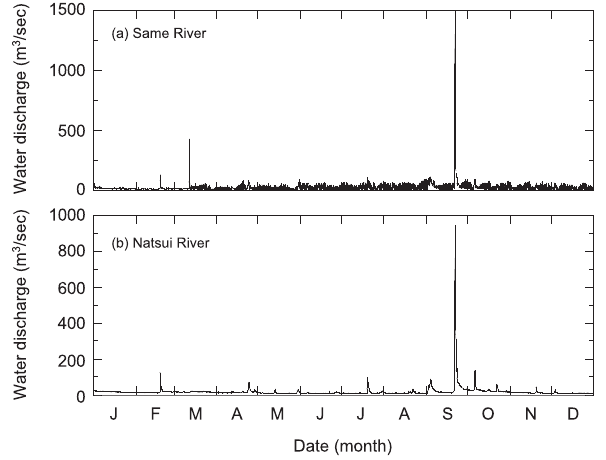
Fig. 2. Water discharge of the Natsui River and the Same River in 2011. Data were referred from the Fukushima Prefectural Govern- ment.